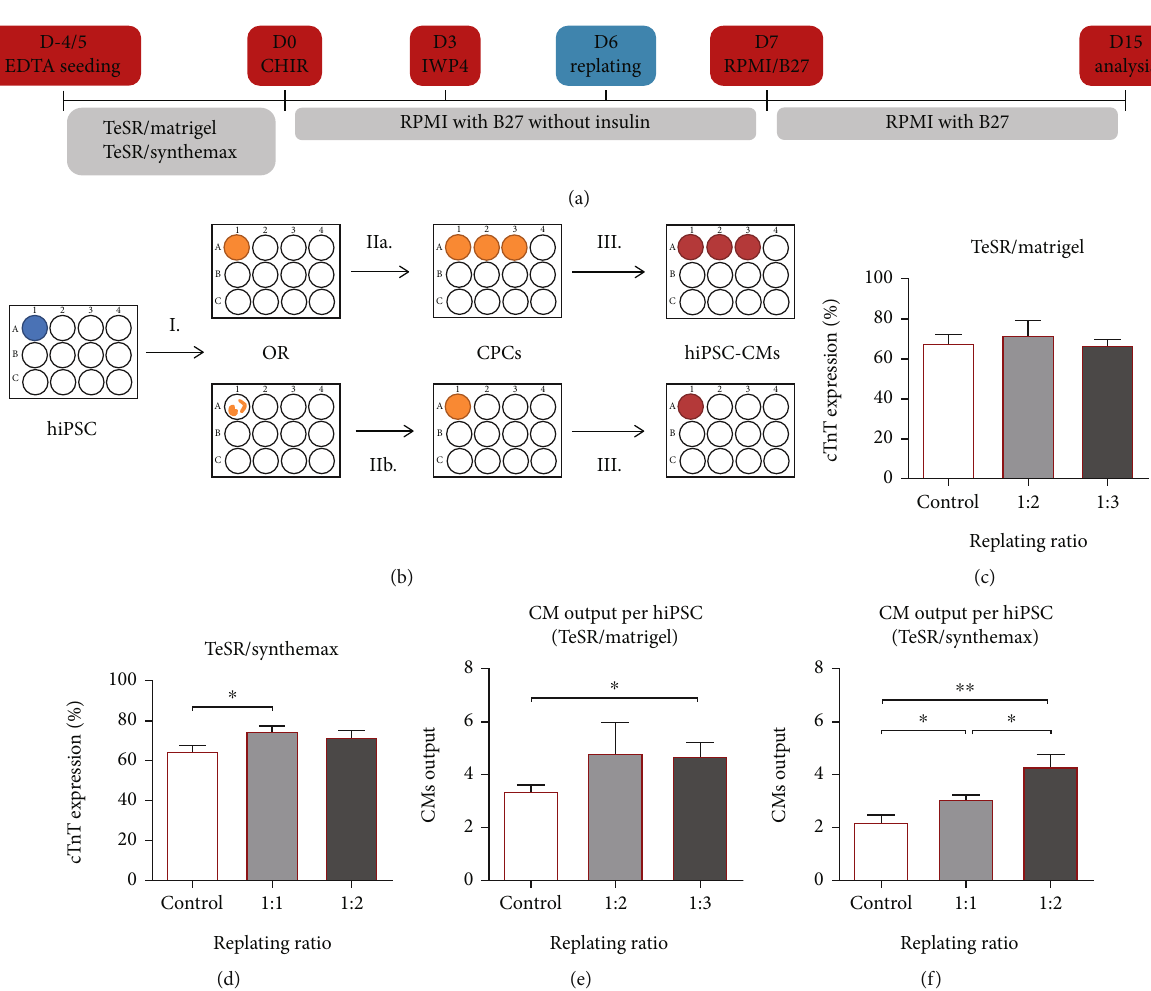
Figure 2: Replating step increased cell sheet integrity and cardiomyocyte output. (a) Modi fi cation of the WNT signaling modulation protocol by adding a replating step at day 6. (b) After initial WNT modulation steps (I.), addition of the replating step increased CM sheet output (IIa.) and for xeno-free systems (e.g., TeSR/Synthemax) reestablished the CM sheet after severe detachment (IIb.)